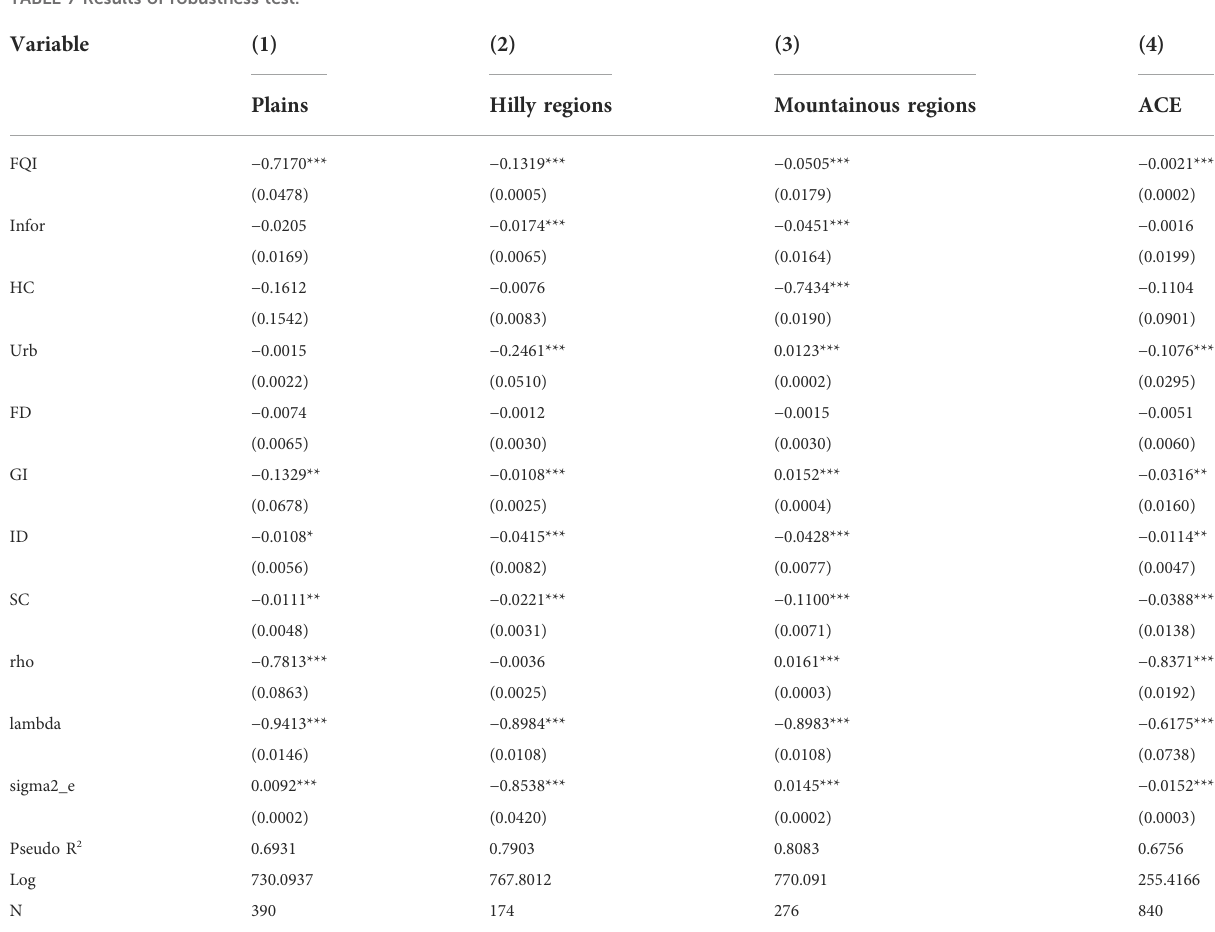
TABLE 7 Results of robustness